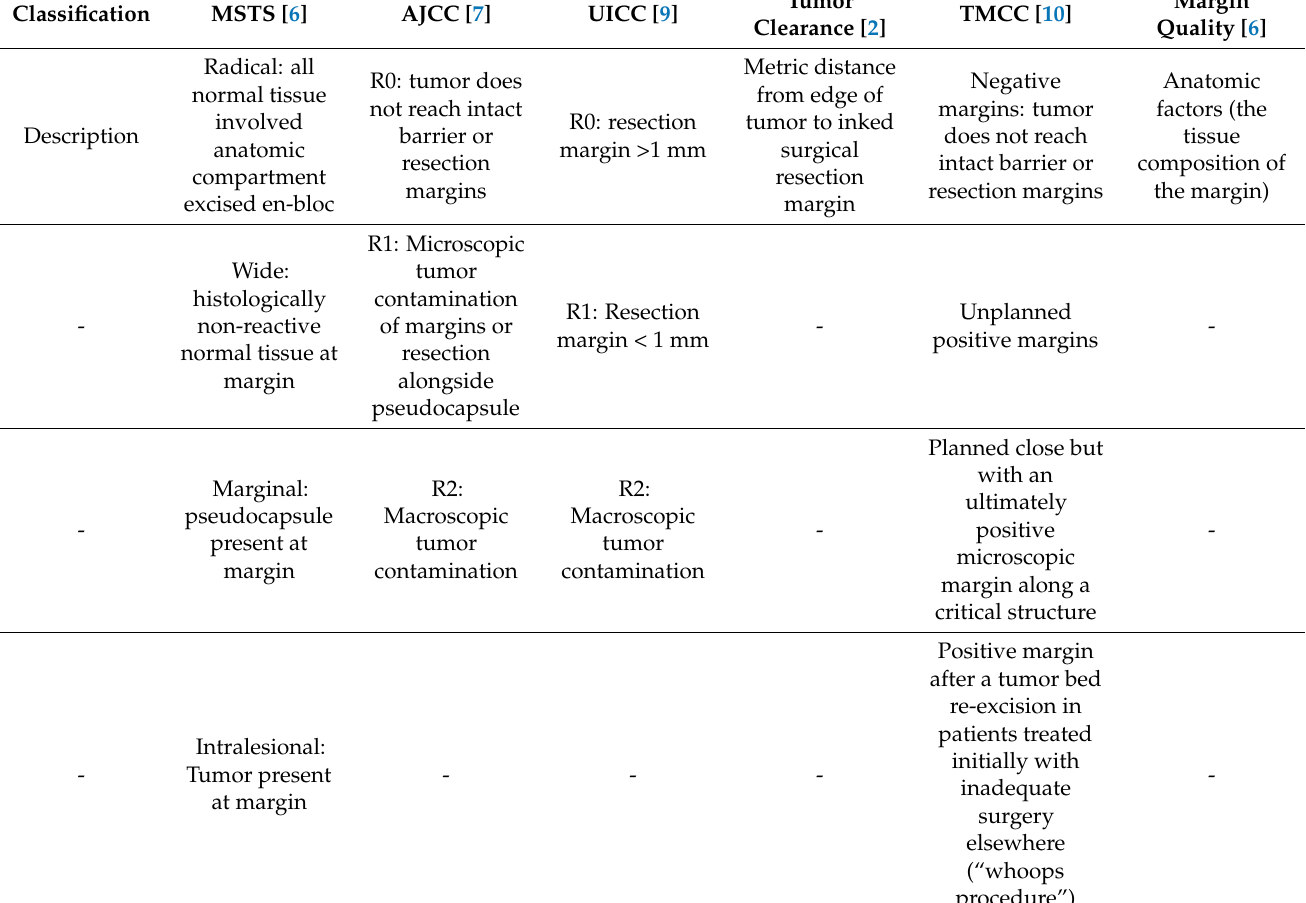
Table 1. Classifications of margins in soft tissue